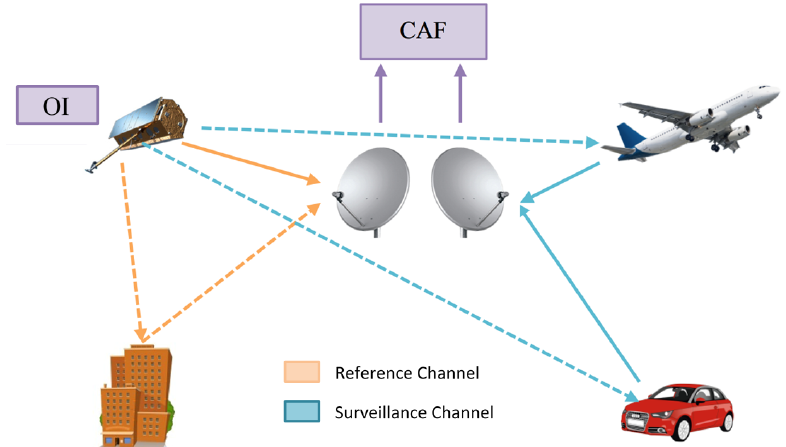
Figure 2. Example of passive radar